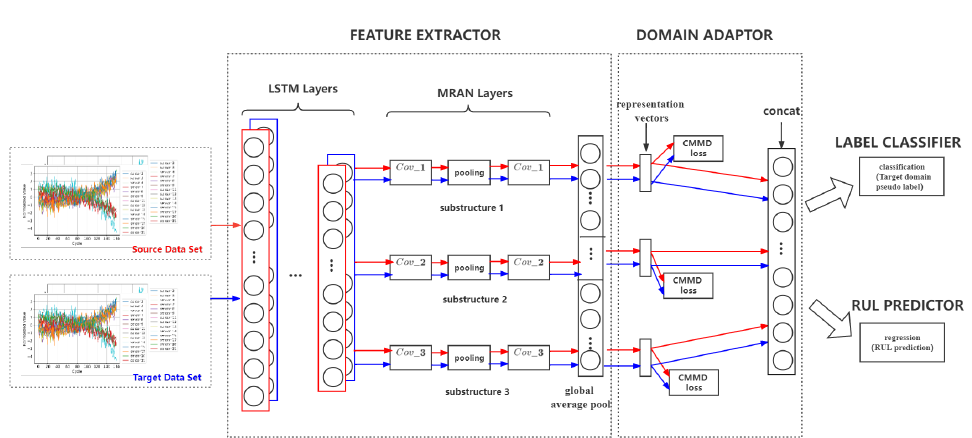
Figure 1. Network structure of